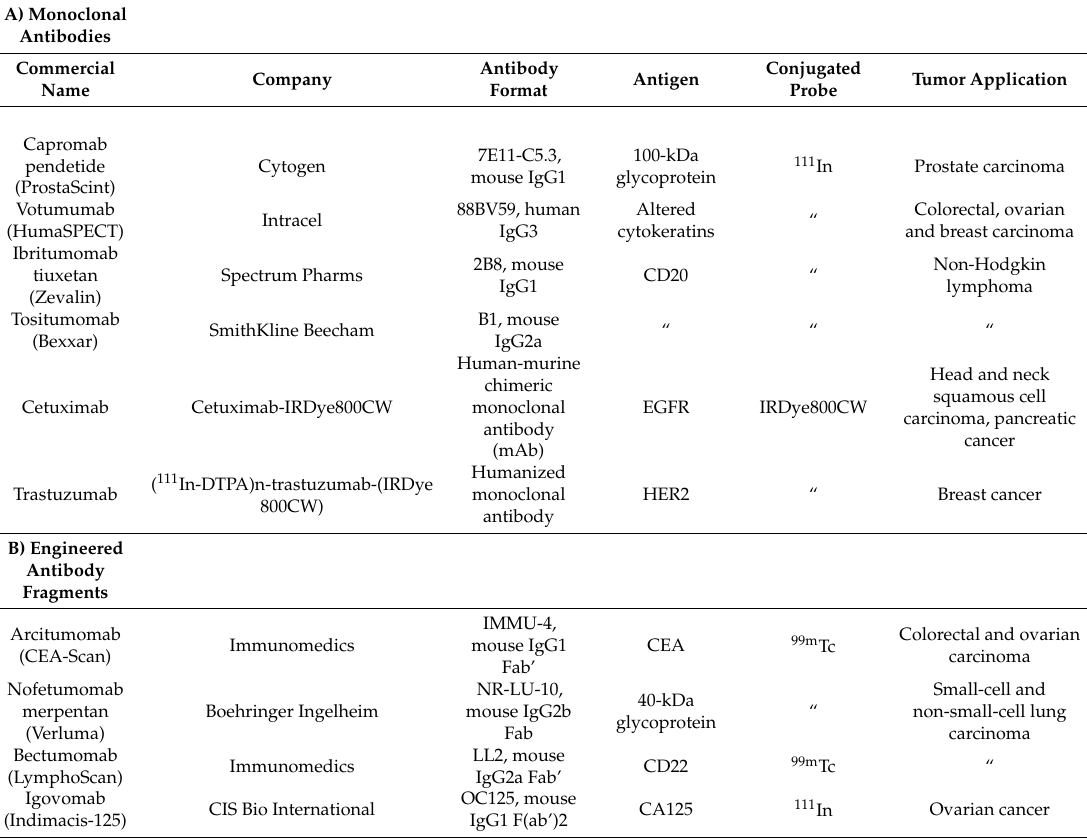
Table 2. Antibodies for in vivo use in tumor imaging diagnostics approved by the FDA and / or EMA and present on the market. CEA, carcinoembryonic antigen; Tc, technetium; In,